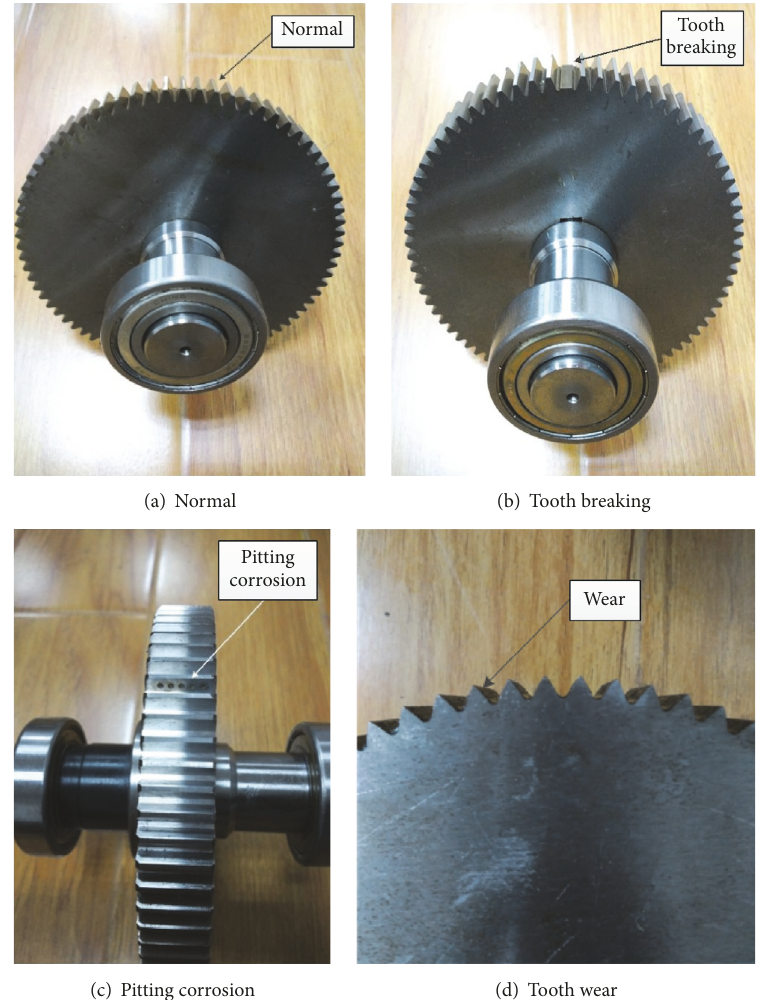
Figure 6: Simulation of gear fault